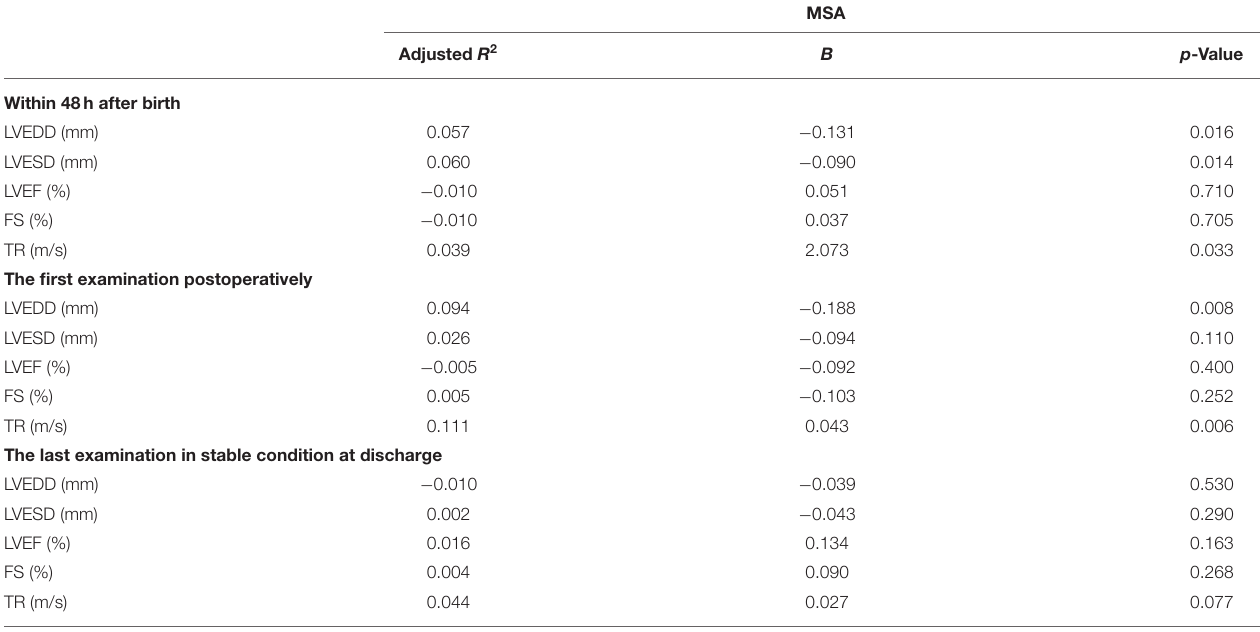
TABLE 6 | Association between MSA value and parameters of echocardiogram within 48h after birth, the first one postoperatively, and the last one before